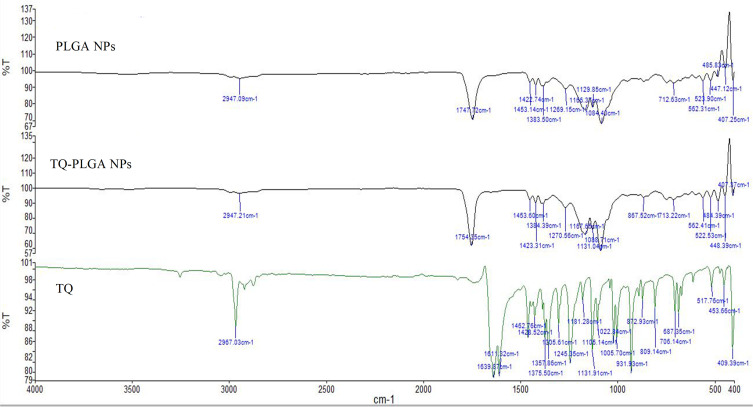
ATR-FTIR spectra of PLGA NPs, TQ-PLGA NPs, and TQ.